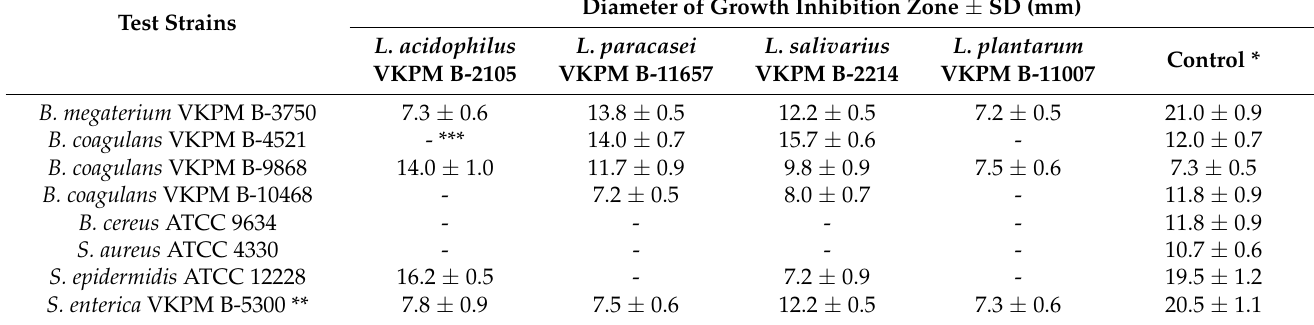
Table 4. Diameters of growth inhibition zones for the CFS of lactobacilli cultivated in MRS against test